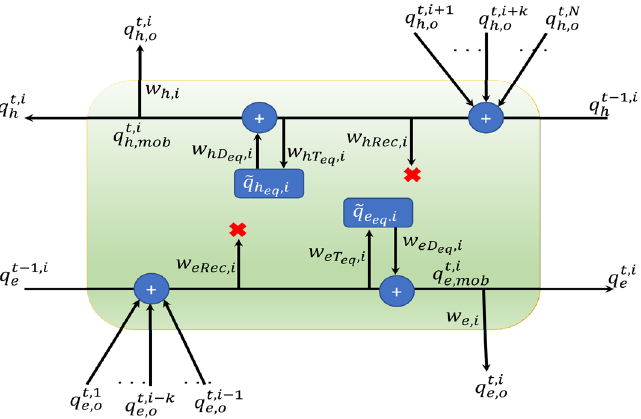
Figure 4. Equivalent Operations in voxel i at time t